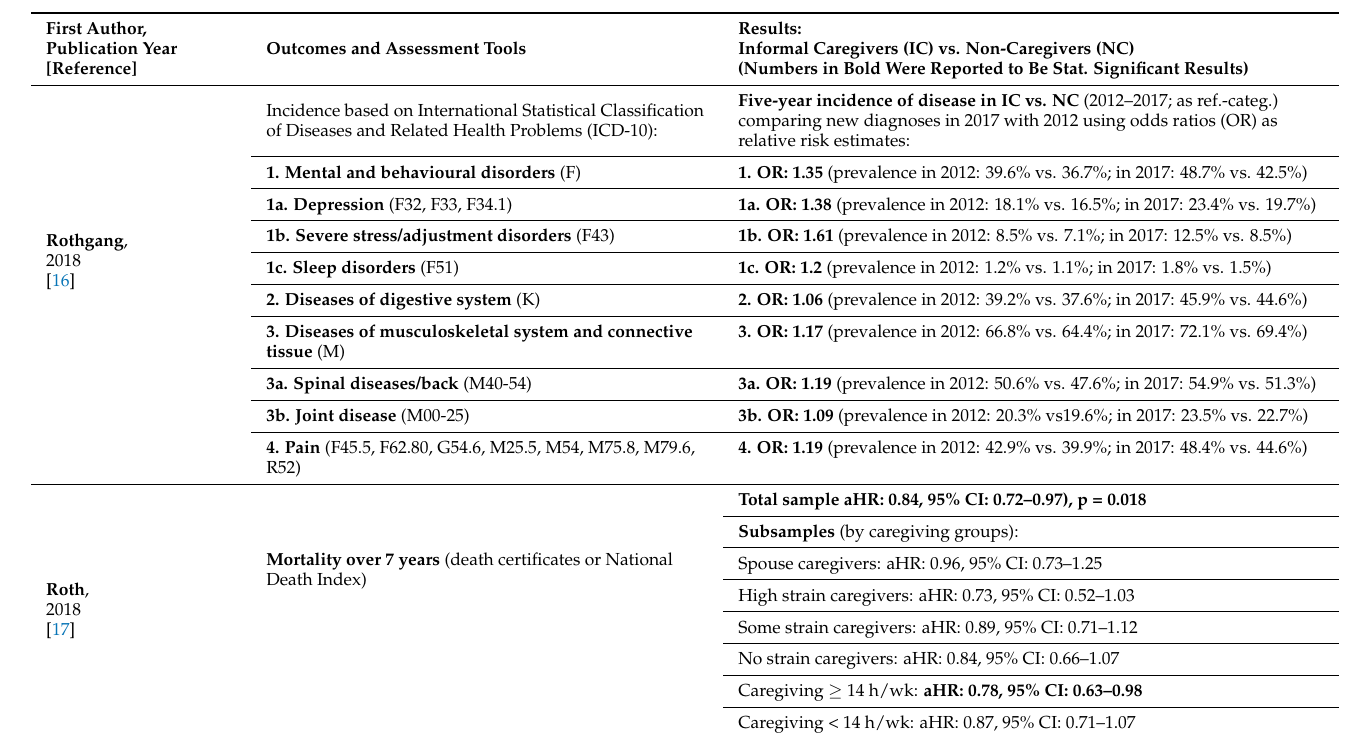
Table 3. Longitudinal evaluations: disease burden outcomes among informal caregivers (IC) com- pared with non-caregivers